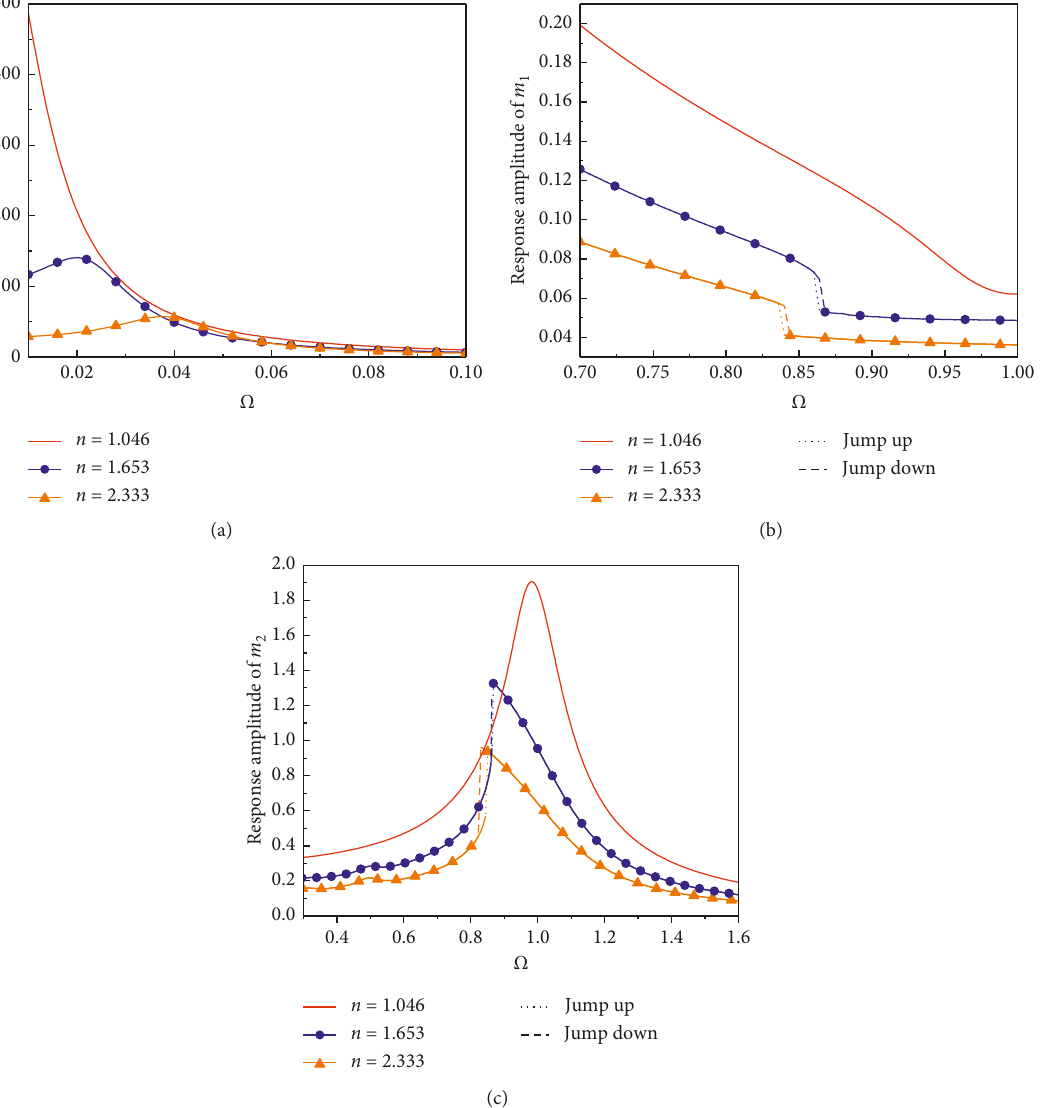
Figure 10: Frequency response curves for different rough surfaces: (a) resonance curves of the reaction mass; (b) response amplitude of the reaction mass; (c) response amplitude of the